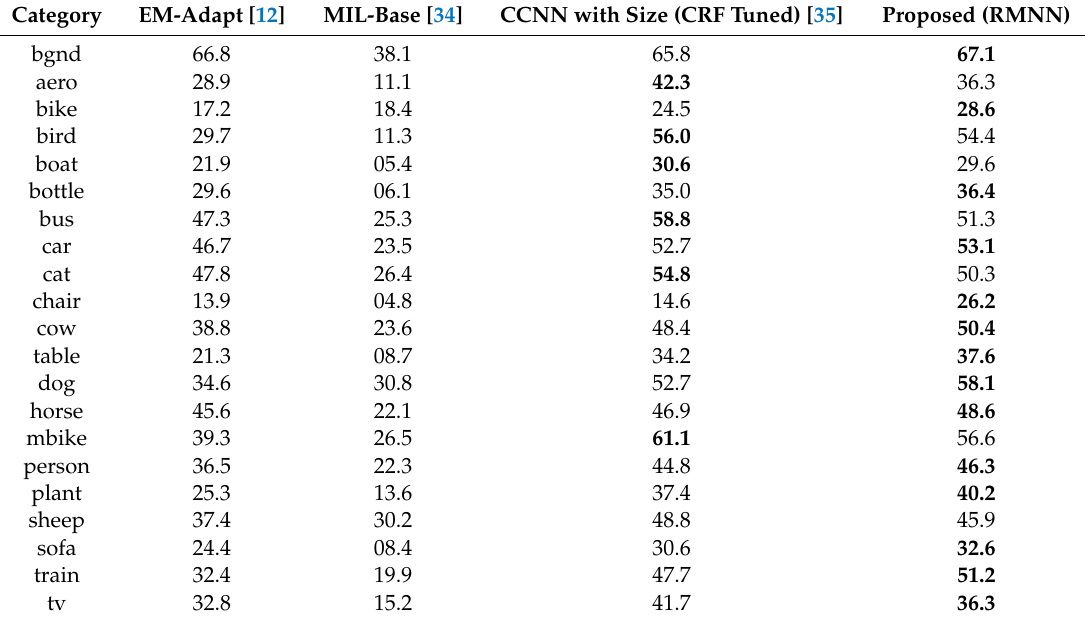
Table 1. Comparison of several weakly-supervised semantic segmentation methods on PASCAL VOC 2012 data set, the IoU score for each level of the VOC data set is presented and the best performance is highlighted in